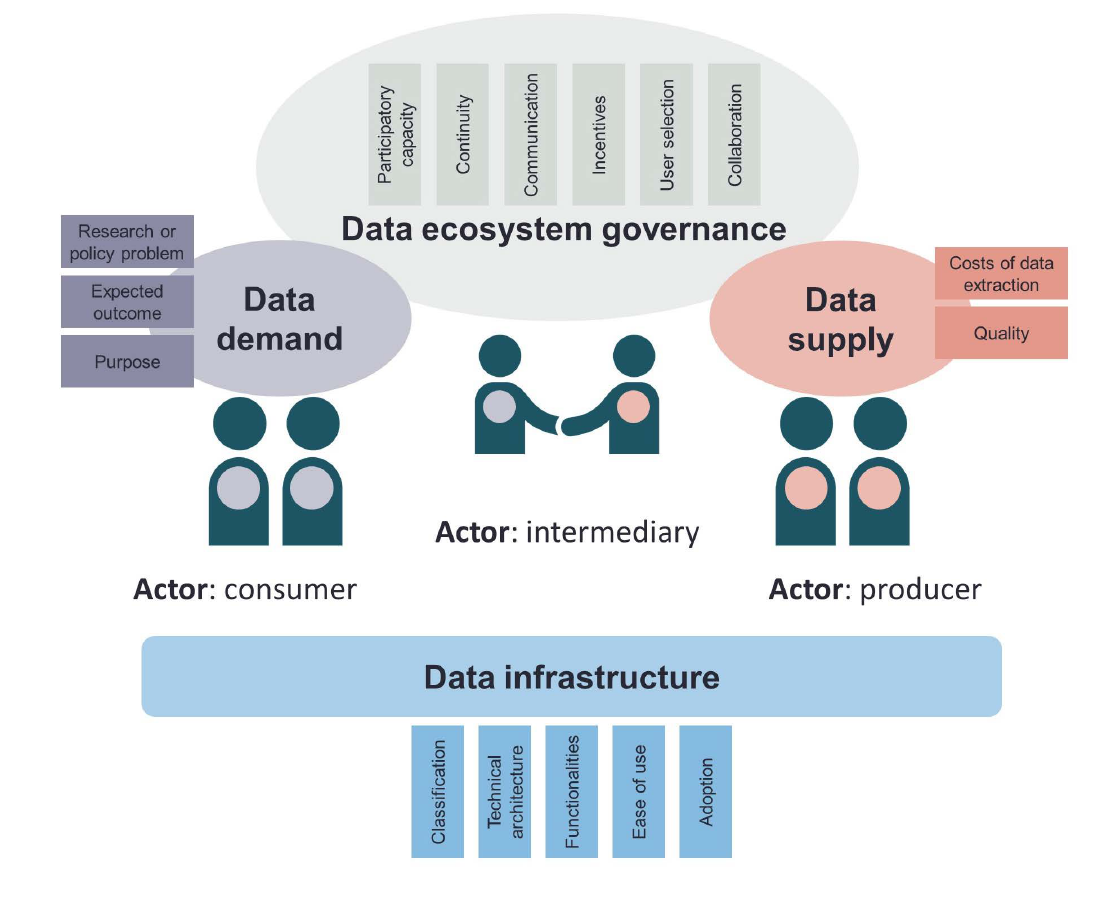
Figure 1. An integrated framework to characterize data